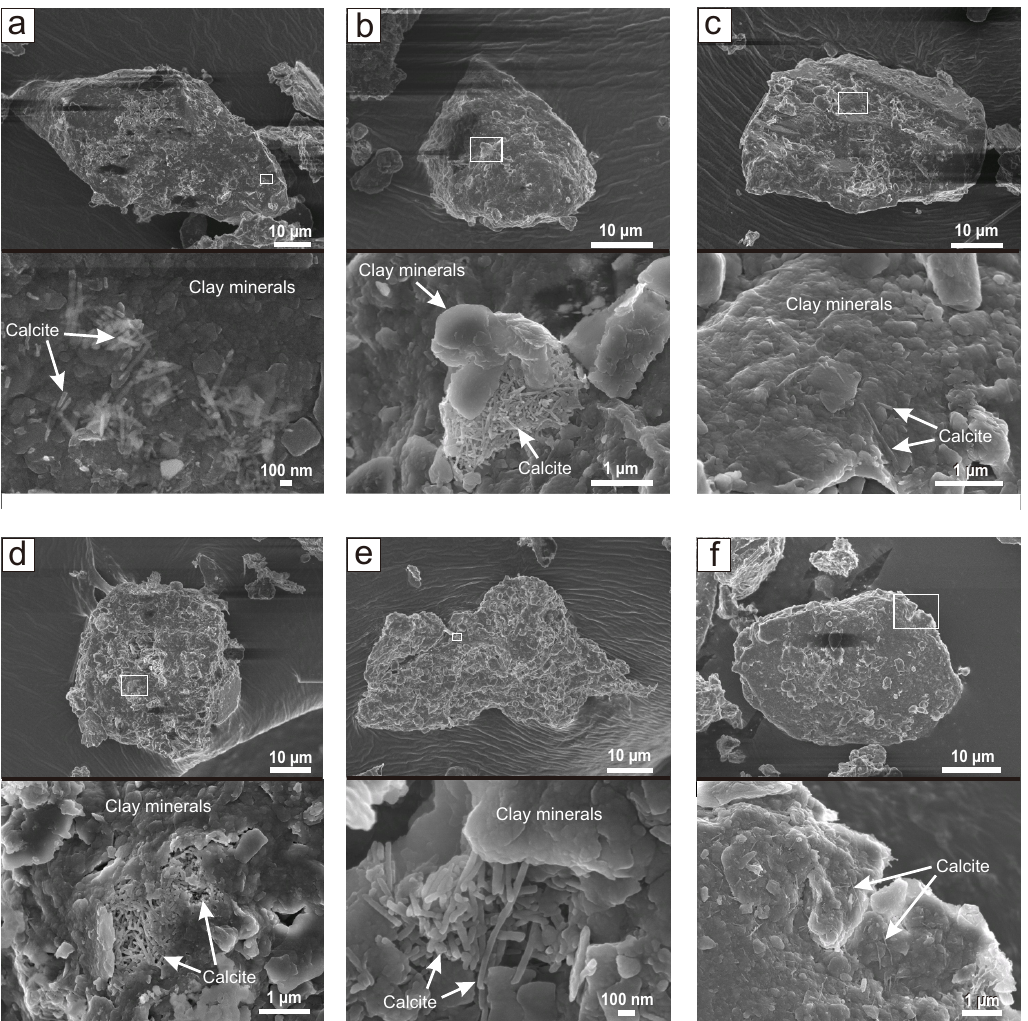
Fig. 4. High-resolution SEM images of the surfaces of giant-L dust particles. Bottom image was magnified from the box in the upper image. (a, b) Quartz particles coated with thin layers of clay platelets and intergrowth of calcite nanofibers. (c) Plagioclase coated with thin layers of clay platelets and calcite nanofibers. (d, e) Agglomerates of clay platelets with intergrowths of calcite nanofibers. (f) Kaolinite with calcite